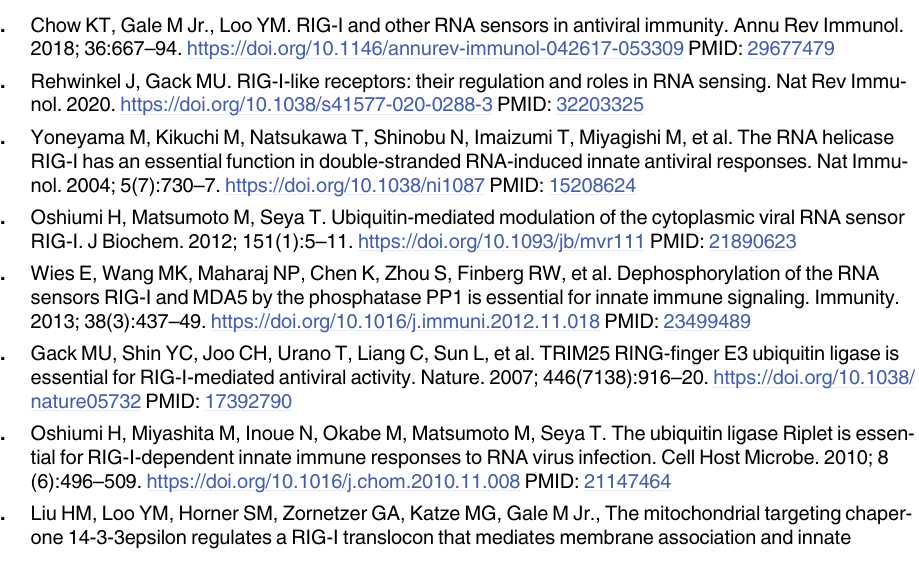
S1 Table. Primers used for